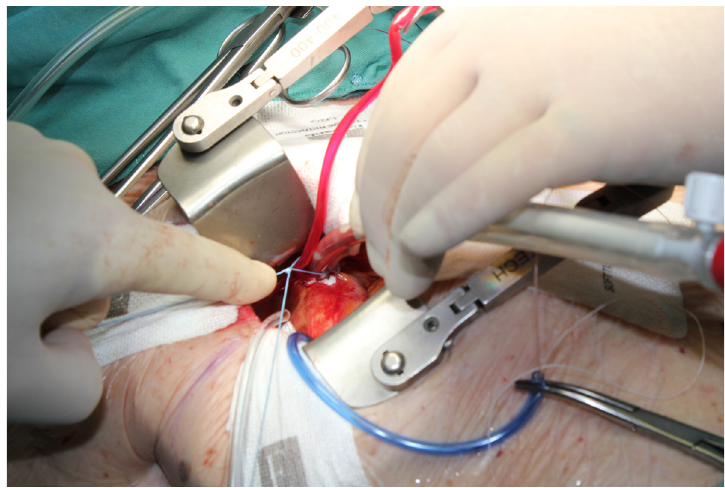
Fig. 2 - The three pericardial retraction stitches through the thoracic wall.